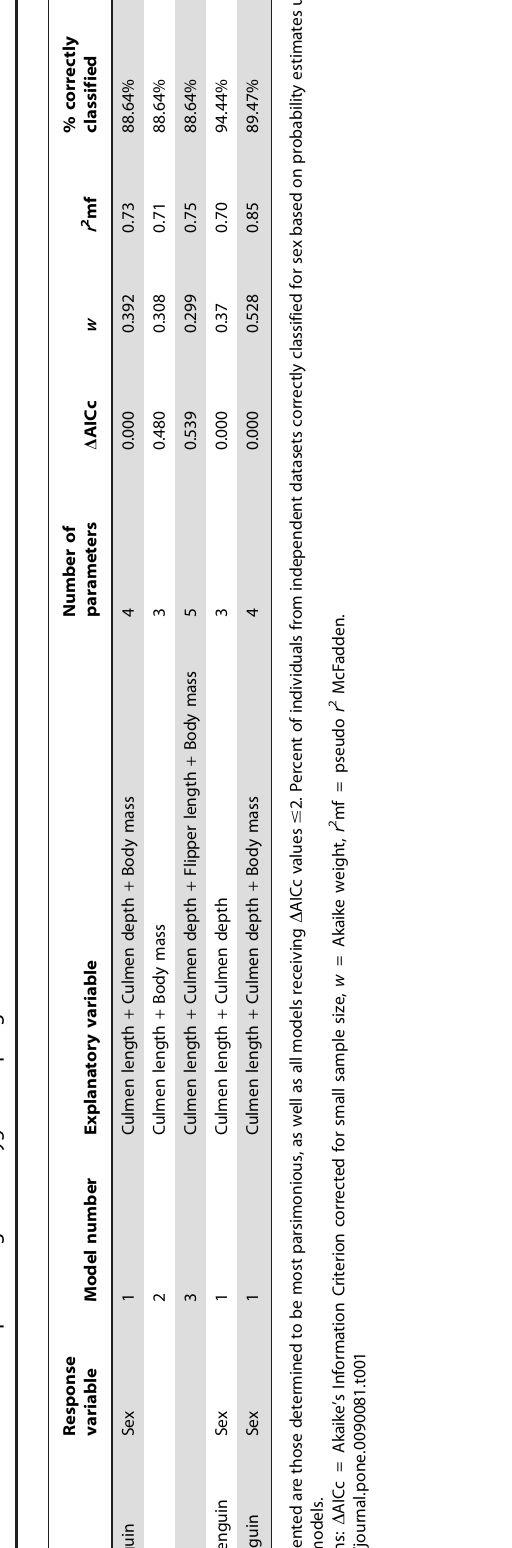
Sea ice metrics indicated that the austral winters preceding each